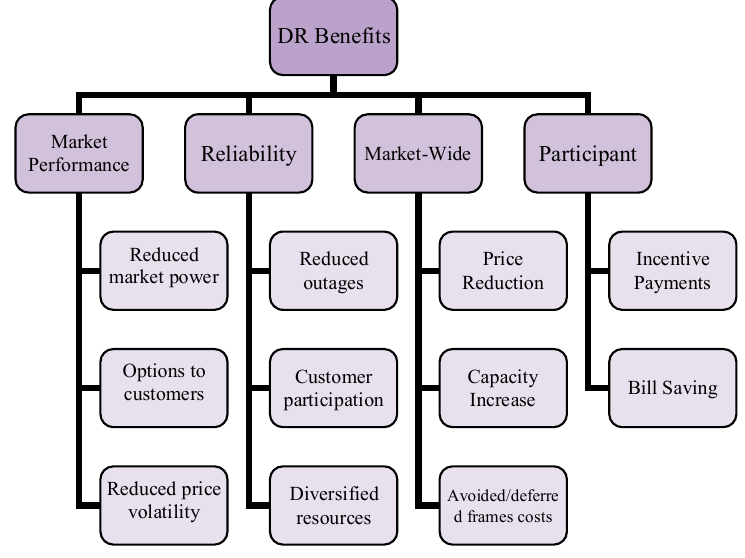
Figure 6. Classification of demand response (DR) benefits [3].